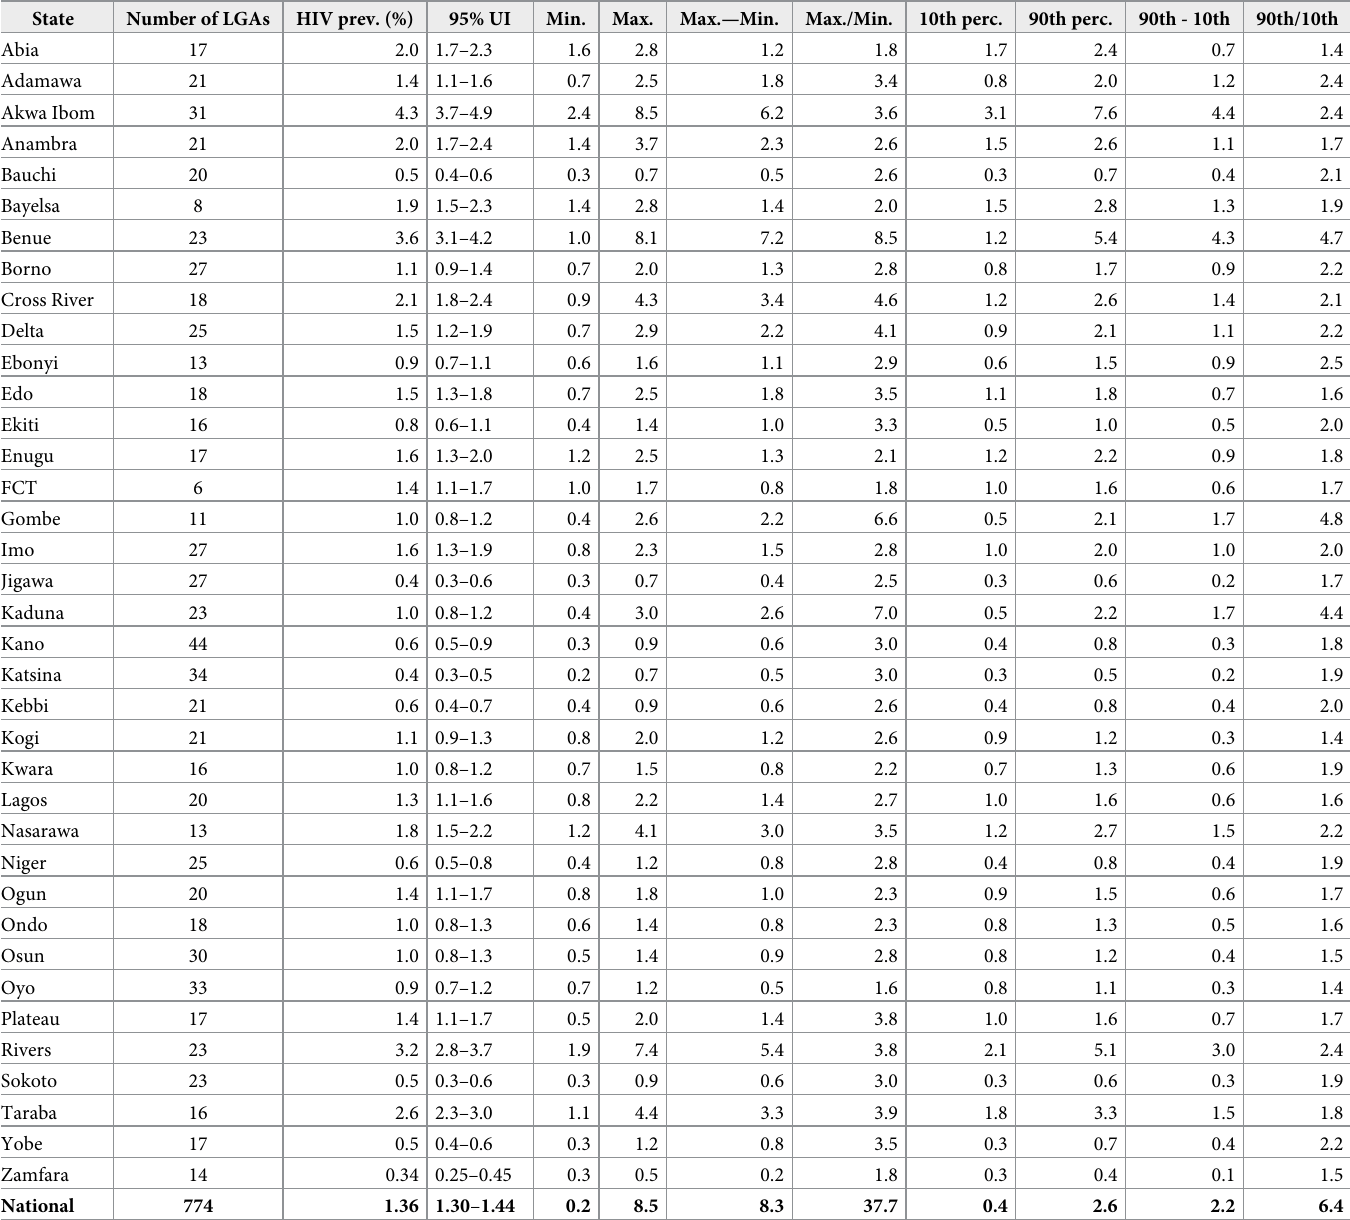
Table 3. Differences in in HIV prevalence between local government areas within states in Nigeria